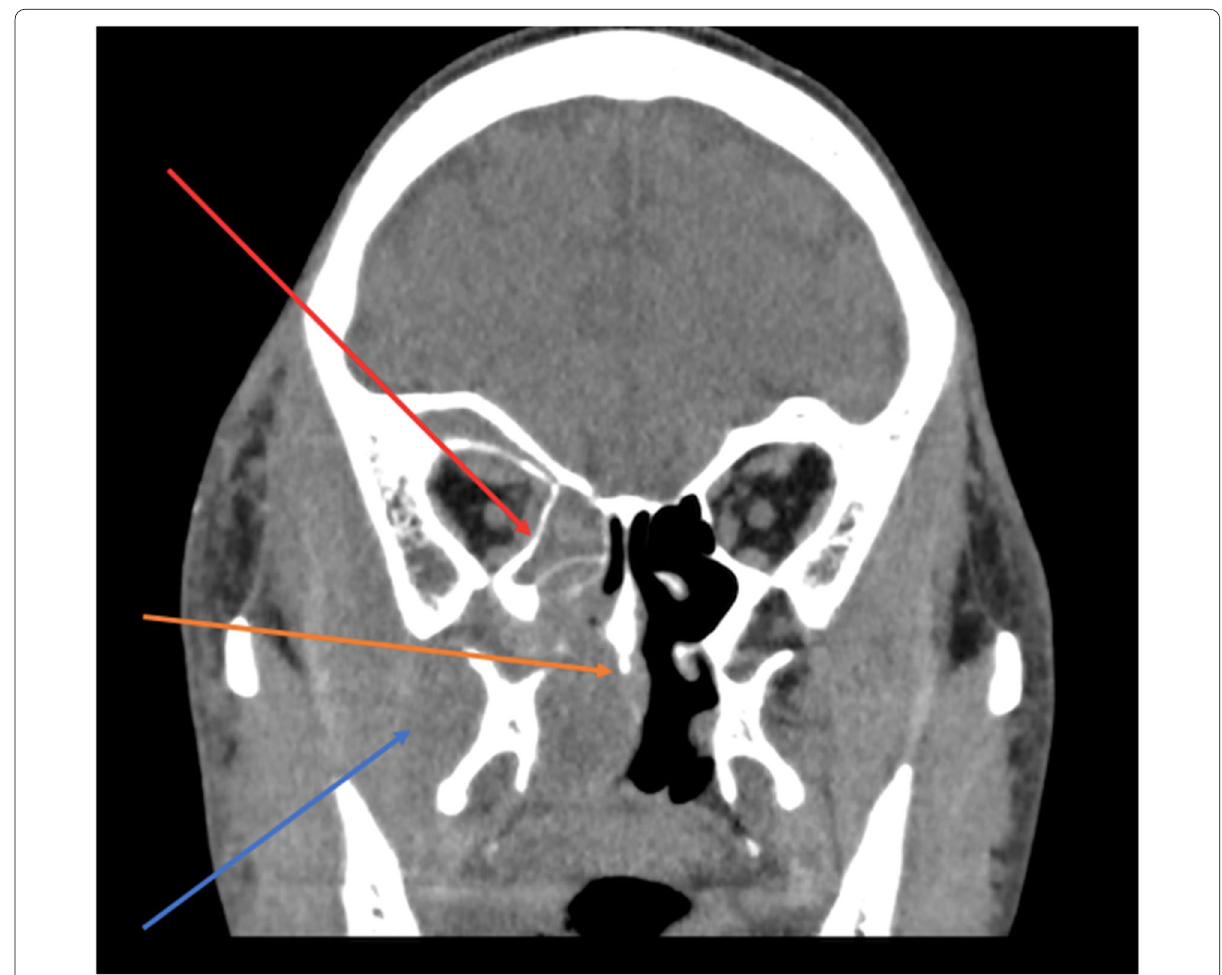
Fig. 4 CT coronal view - right buccal mass extending into the right orbit and right sinonasal